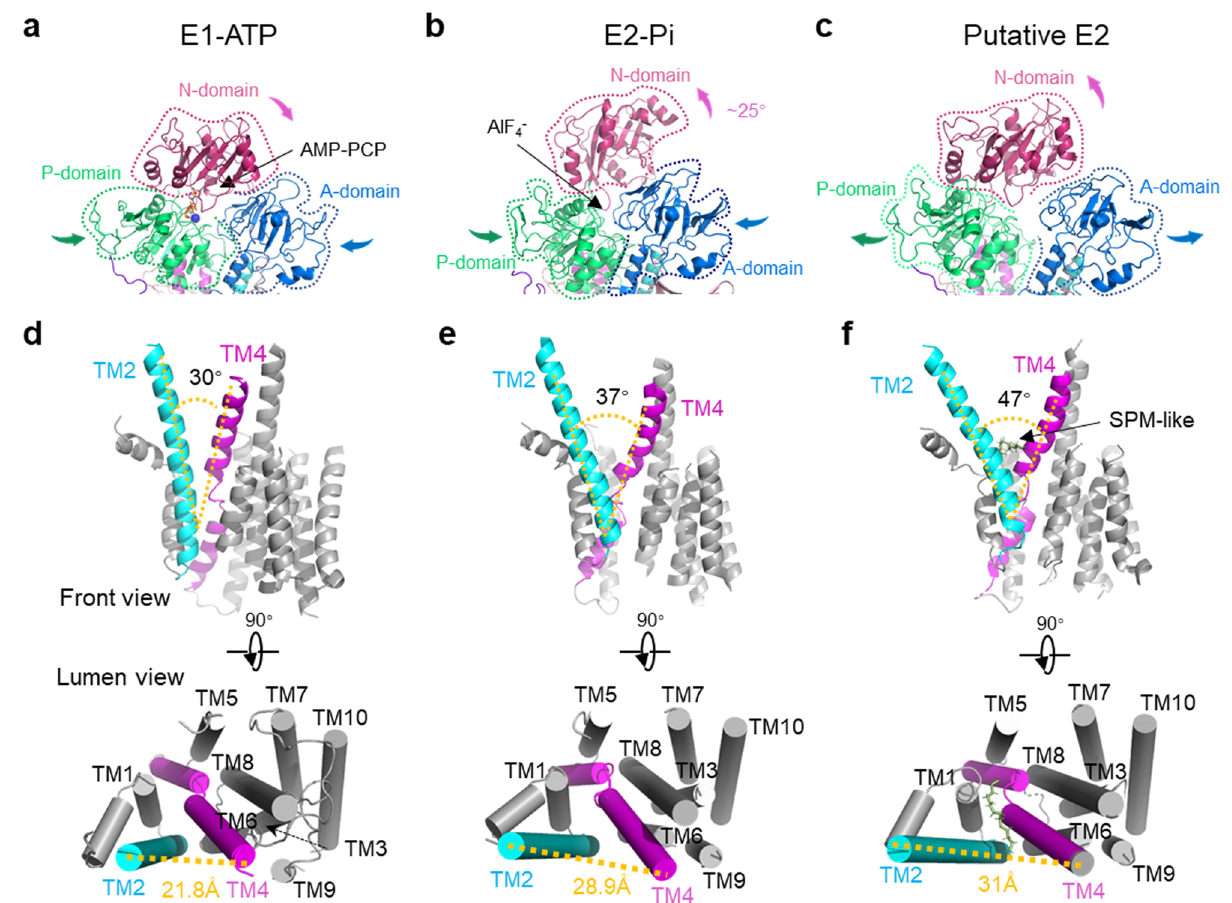
TM2andTM4bfromthefrontviewandtheluminalviewofE1-ATP( d ),E2-Pi( e ),and putative E2 states ( f ), respectively. The counterpart angle is marked by the yellow- dotted line. The distances between the ends of TM2 and TM4b are